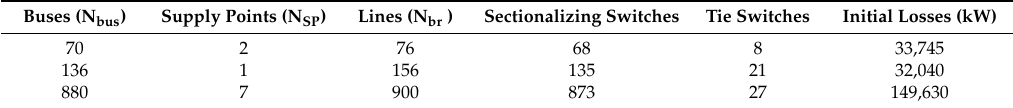
Table 1. Basic network data for 70, 136 and 880 bus